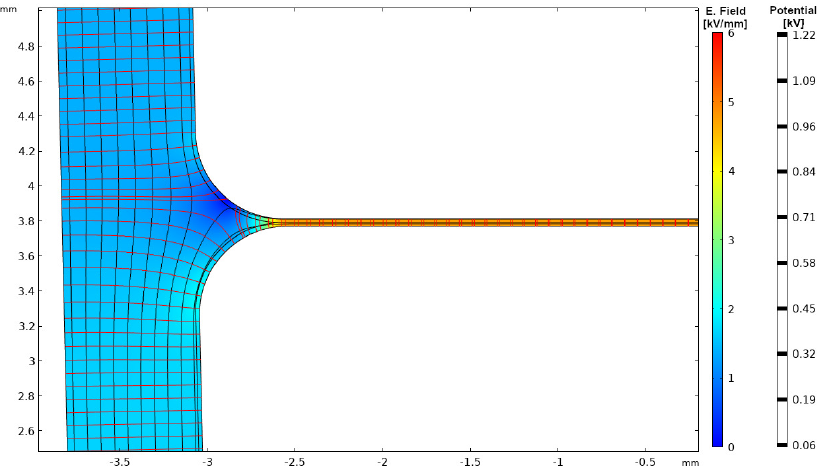
Figure 8. Electric field distribution in the slot considering the worst condition for the turn-to- turn insulation (benign condition). Only the turn-to-turn insulation applied in this figure, but no slot